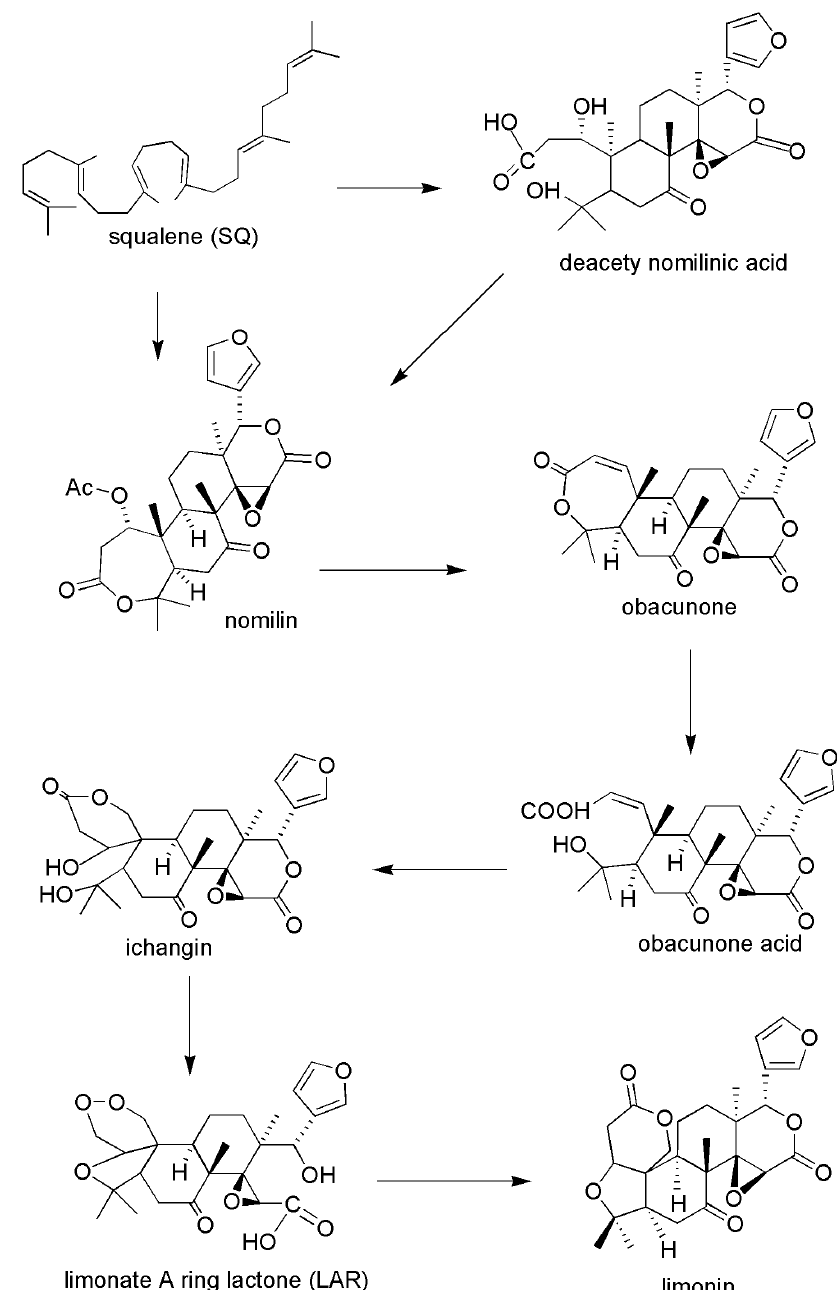
Figure 2. Biosynthetic pathways of limonin in citrus fruit. Table 1. Plants containing limonin.